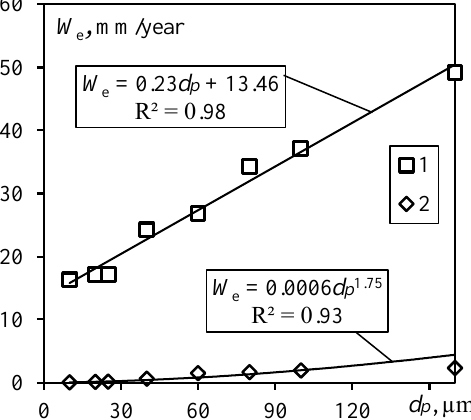
Figure 9. The erosive wear rate W e , mm/year as a function of particle diameter for different devices: (1) the cyclone and (2) the separator with arc-shaped elements.